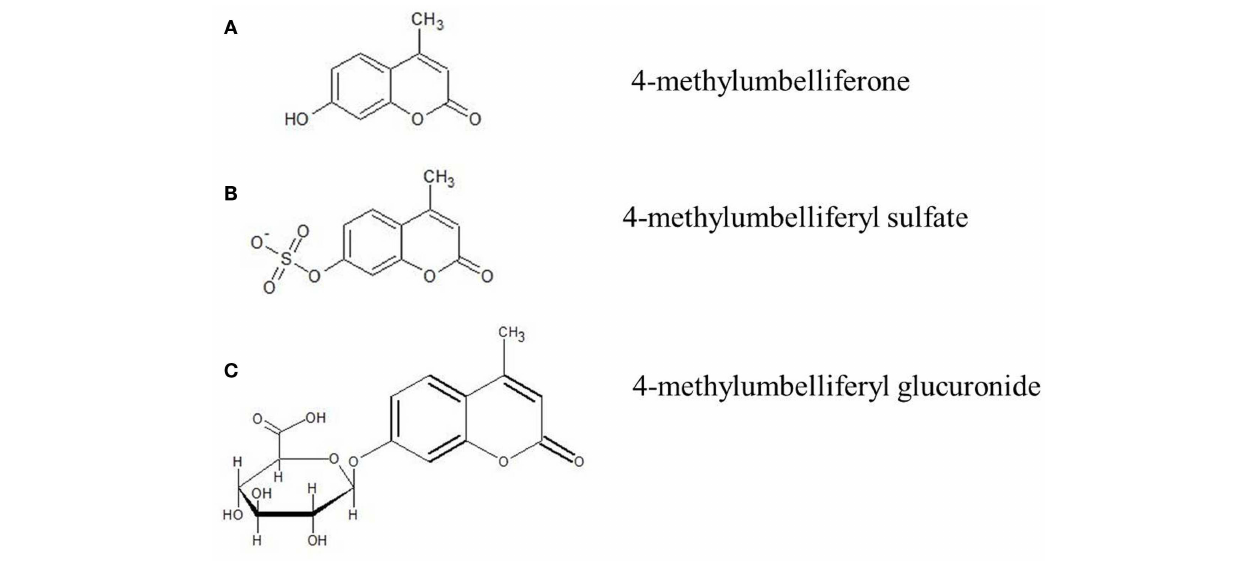
FIGURE 1 | Molecular structure of 4-MU and its metabolites . (A) 4-Methylumbelliferone (4-MU), (B) 4-methylumbelliferyl sulfate (4-MUS), (C) 4-methylumbelliferyl glucuronide